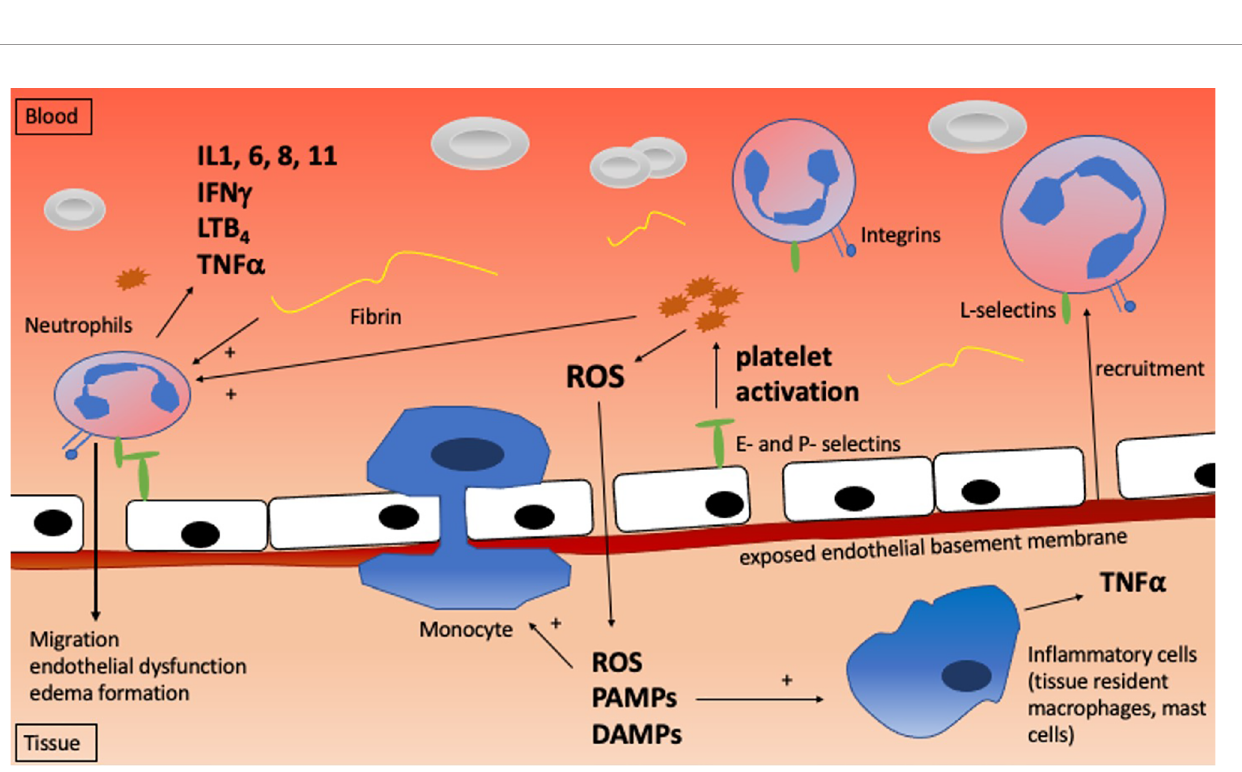
FIGURE 1 | The molecular mechanisms involved in ischemia reperfusion injury and how they interact with one another.